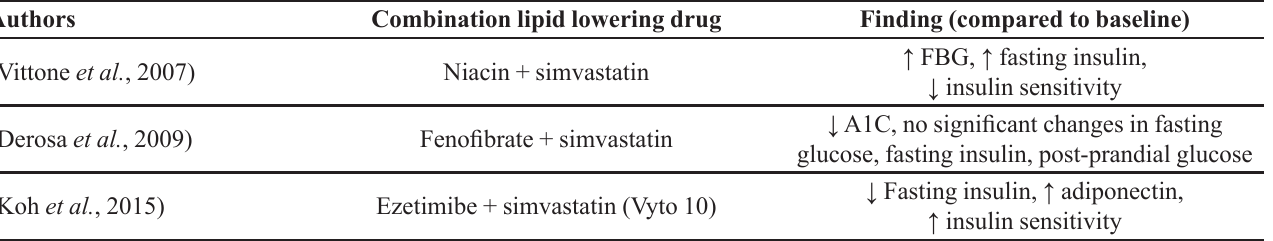
TABLE III - Summary effects of simvastatin in combination with other lipid lowering medications based on previous studies